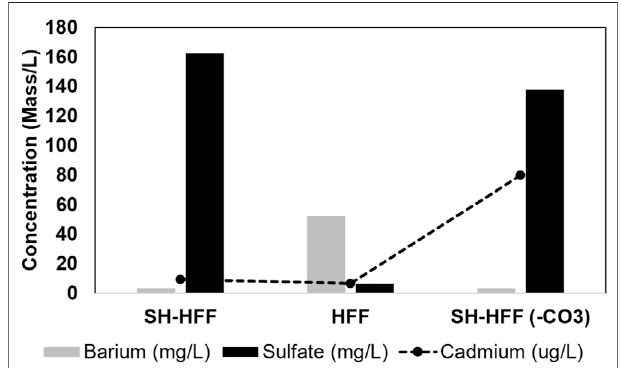
FIGURE9| Barium andsulfateionsinsolutionindicating limitingreagent or barite precipitation. Cadmium is plotted as a proxy for pyrite dissolution vs sulfate in